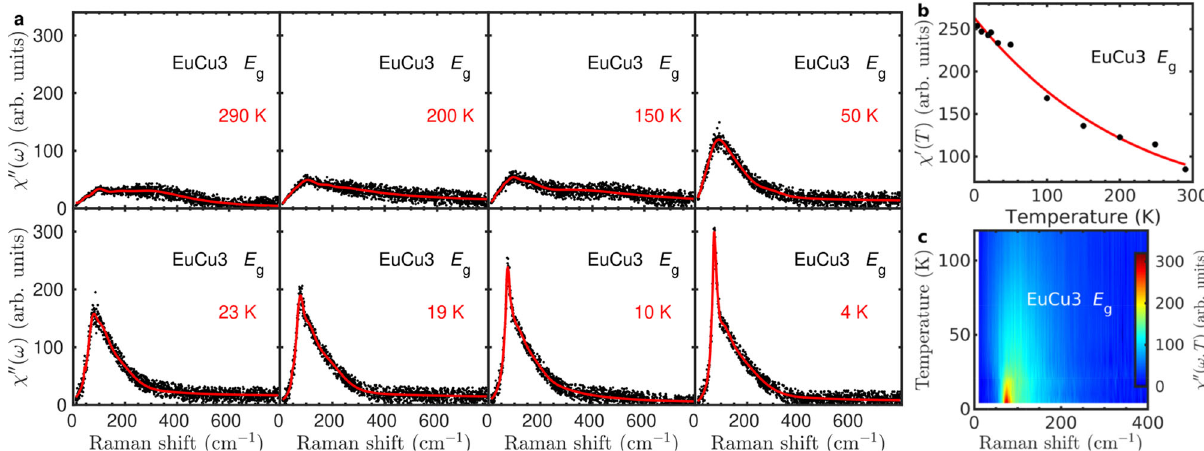
¼ χ 00 . The solid lines are guides to the eye. A XY g ð ω ; T Þ E g